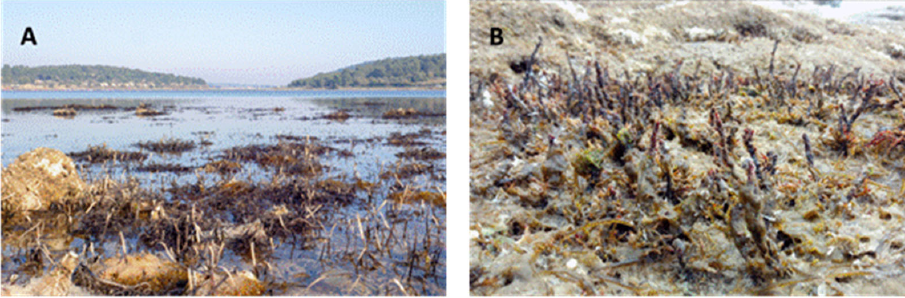
Figure 6. Fucalean species damaged during springtime low water-high air temperature event on southern ( A ) and western ( B ) Istrian coast.